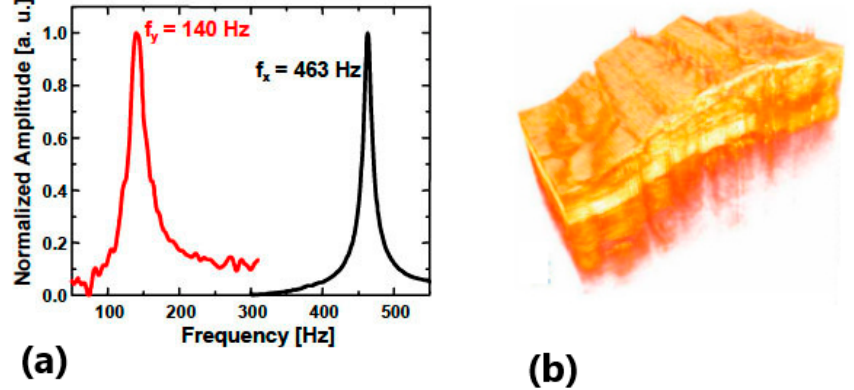
Figure 10. Resonance characteristics of the MEMS scanner ( a ); and 3D OCT image acquired in vivo set from the hamster cheek pouch ( b ) (Figures from [47]).